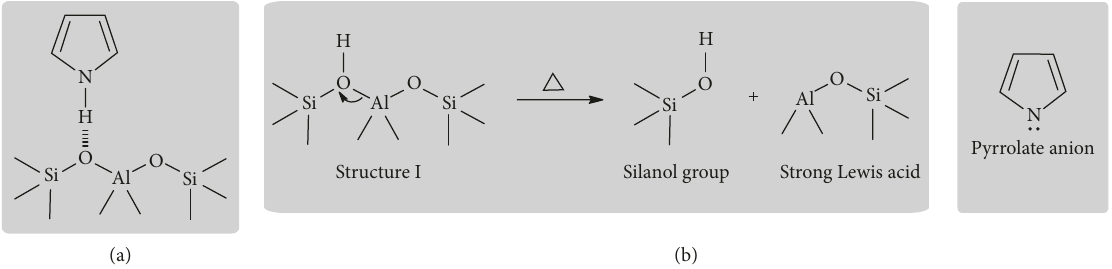
Figure 3: Different ways by which pyrrole can be adsorbed by the Saudi grey kaolin: (a) by the lattice oxygen as a Lewis base; (b) by aluminum acting as a Lewis acid.